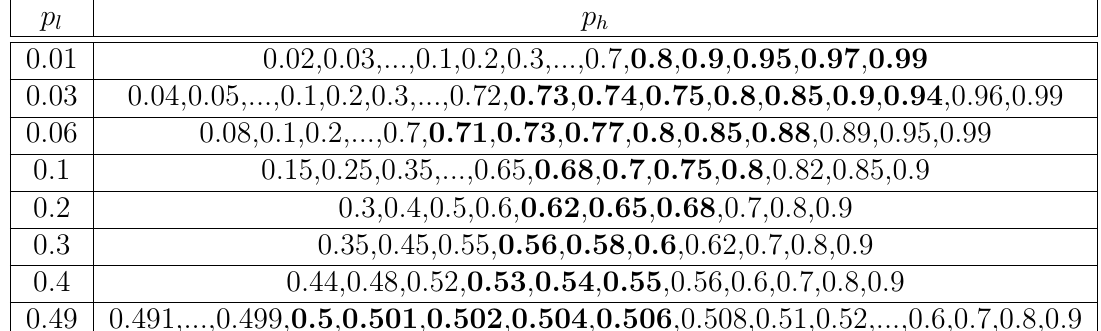
Table 1: Chosen p input length n = 500.